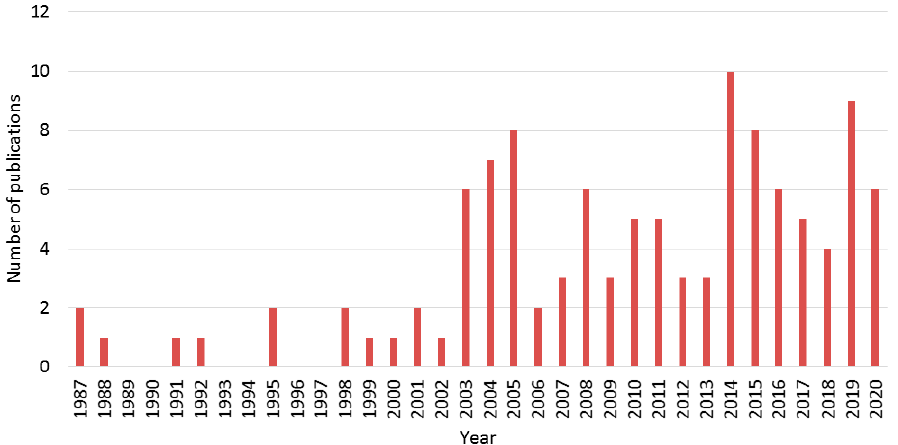
Figure 3. Number of publications per year about colloidal aqueous sol–gel synthesis of TiO 2 materials collected for this review.